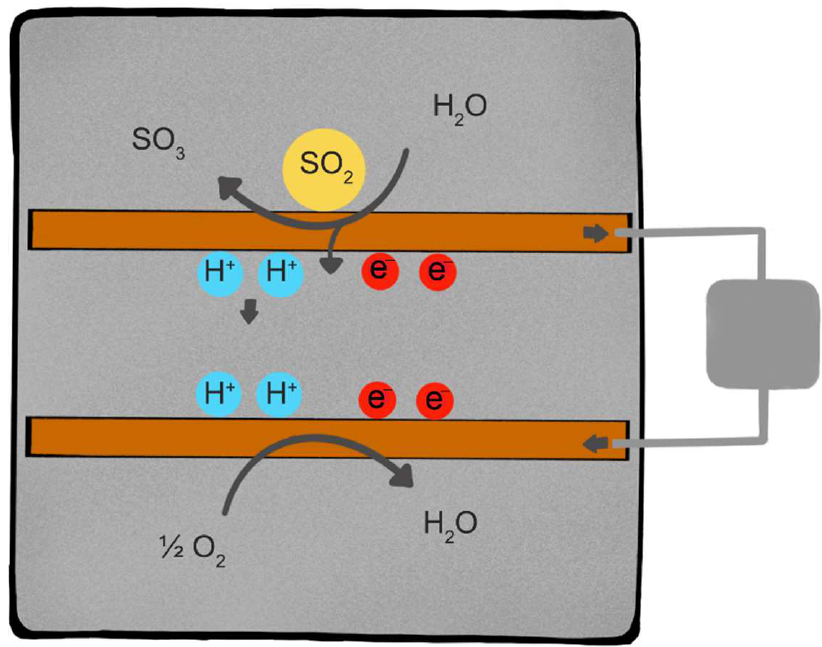
Figure 1. Working principle of a two-electrode electrochemical sensor for detection of SO 2.